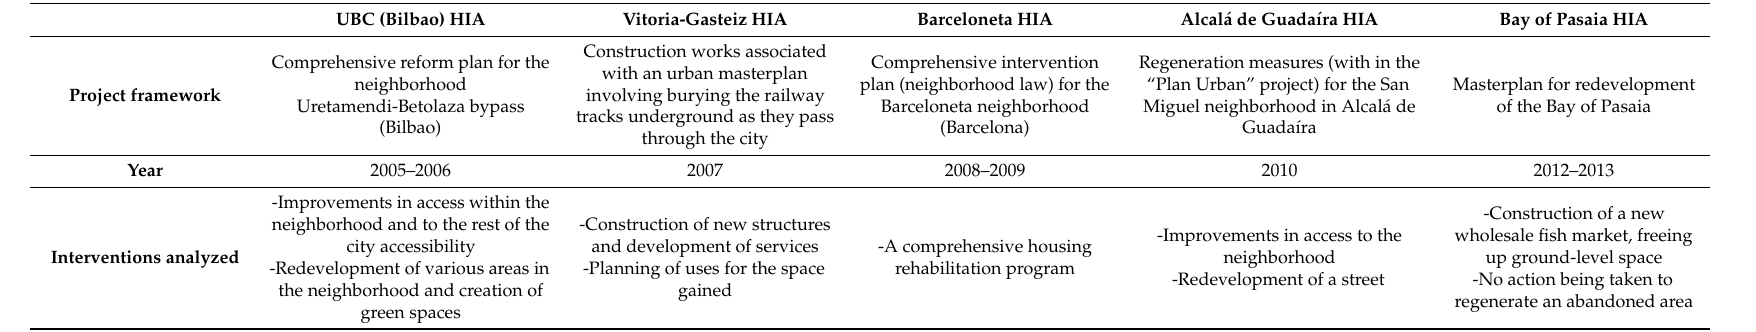
Table 1. Basic characteristics of the health impact assessments (HIAs) analyzed.